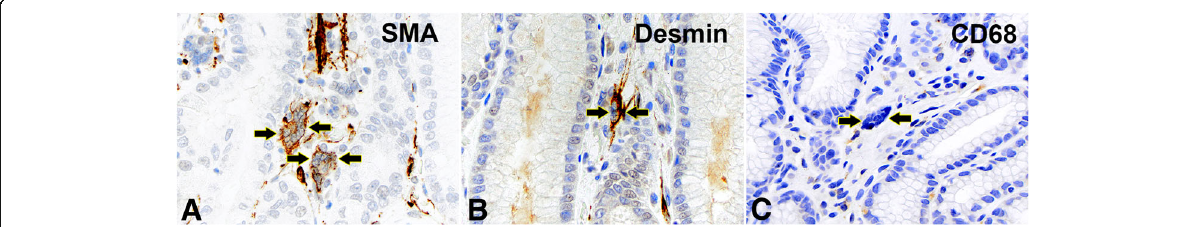
Fig. 2 Immunohistochemical findings of multinucleated stromal giant cells. ( a ) Reactive for smooth muscle actin. ( b ) Reactive (variably) for Desmin. ( c ) Non-reactive for CD68. Original magnification